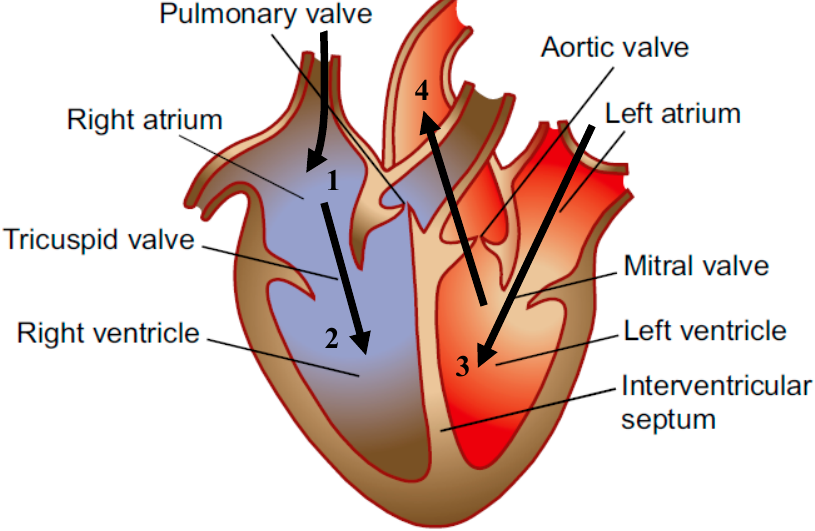
Figure 1. Anatomy of the human heart [4].